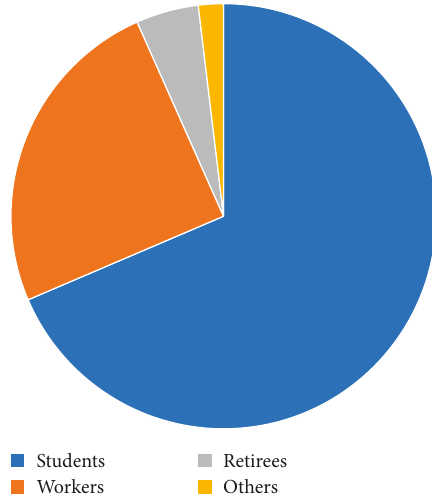
Figure 6: Occupational distribution of